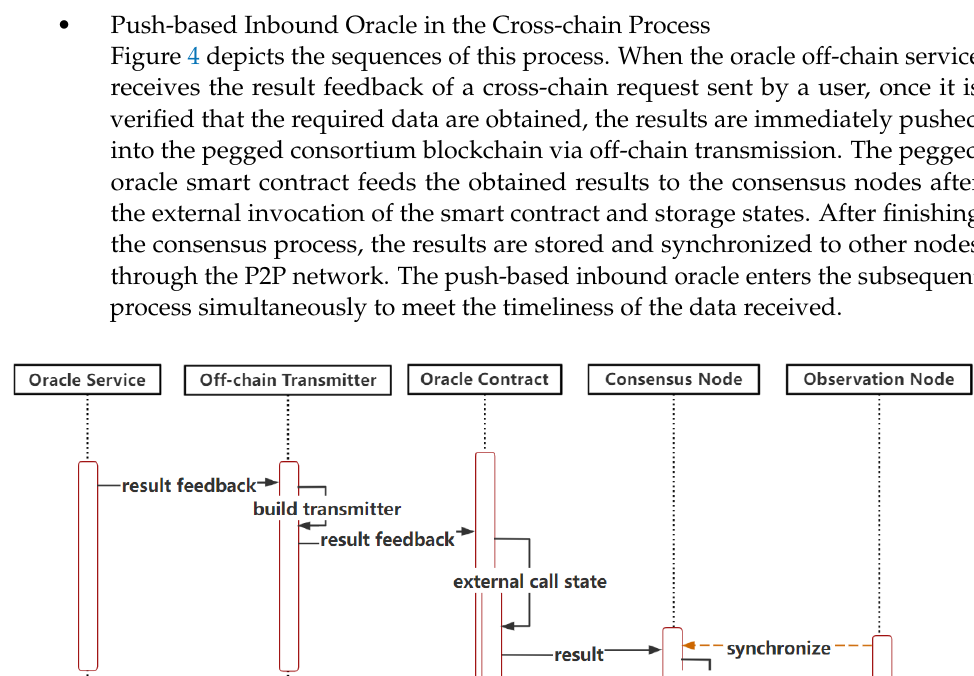
Figure 3. Push-based outbound oracle.